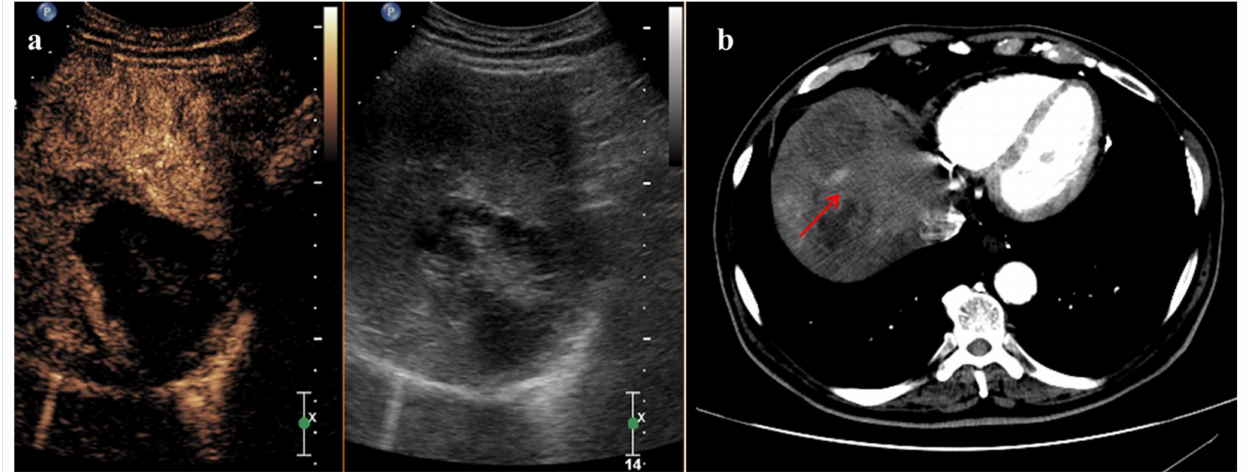
Figure 3. A 5 cm HCC of the segment VIII with discordant behavior after combined therapy (RFA + TACE). ( a ) Arterial phase imaging (22 s after SonoVue injection) shows no enhancement within the lesion. ( b ) Arterial phase CECT scan 1 month after treatment shows the persistence of viable tumor (red arrow) in the upper posterior part of the lesion not detected by